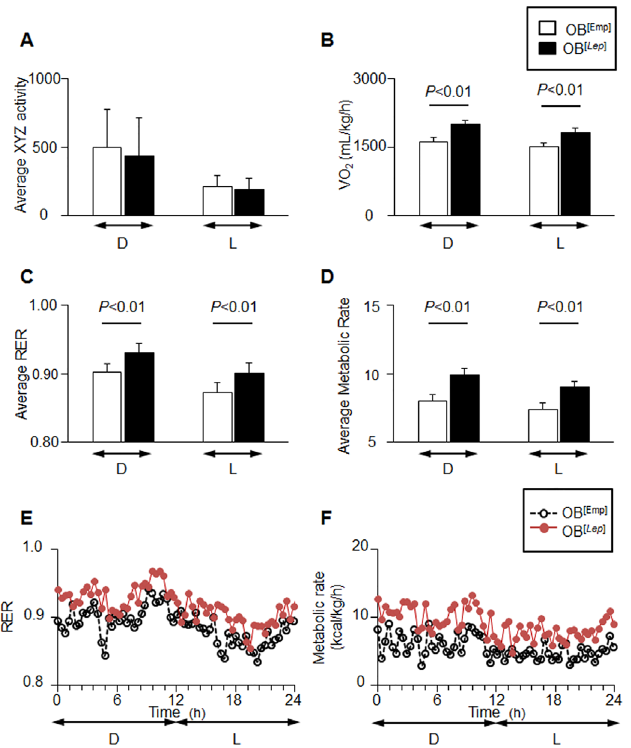
Fig 4. Leptin increases metabolic rate and raises RER. (A-D) Metabolic measurements were performed in OB [Emp] (white bar, n = 5) and OB [ Lep ] (black bar, n = 6) mouse groups in CLAMS metabolic cages at 28 days post injection. Metabolic data for OB [3T3] group are shown in S3 Fig. The average (mean ± SD) x, y, and z activity (A), average VO 2 (mL/kg/h) (B), respiratory exchange ratio (RER) (C), and average metabolic rate (kcal/h/kg) (D) are shown for both the dark (D) and light (L) cycles. (E, F) Kinetic data for RER (E) and metabolic rate (kcal/h/kg) (F) are shown as mean for each time point in OB [Emp] (open black circles) and OB [ Lep ] (filled red circles) groups. Significant differences are shown by black bar and determined by one-way ANOVA followed by Tukey ’ s